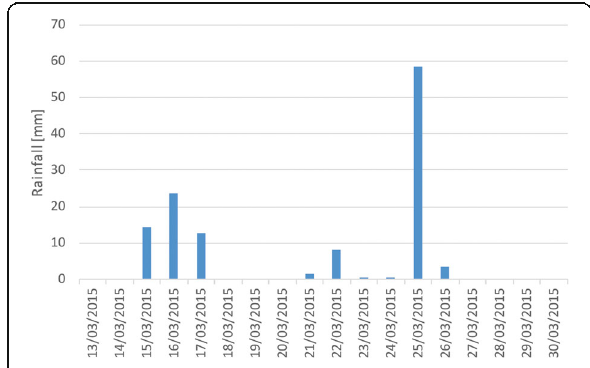
Fig. 3 Daily rainfall intensity from 13/03/2015 to 30/03/2015 Fig. 4 Hourly rainfall intensity on 25/03/2015